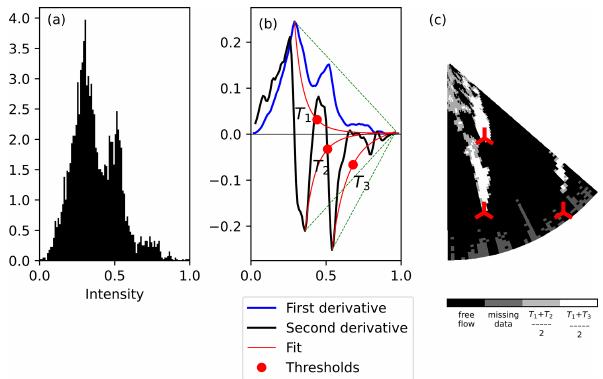
Figure 24. Scan 553 (bimodal subset). (a) Intensity histogram of the normalized data, (b) the ATS method search for the thresholds, and (c) thresholded